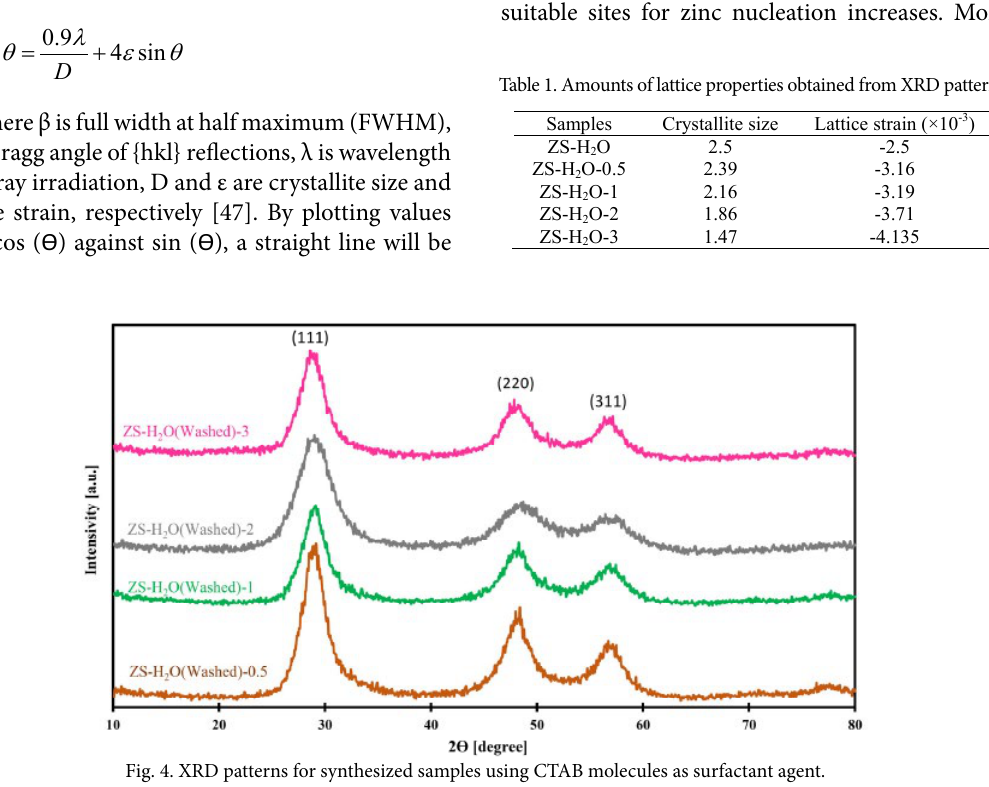
Figure 4 . XRD patterns for the synthesized samples using CTAB molecules as a surfactant agent Fig. 4. XRD patterns for synthesized samples using CTAB molecules as surfactant